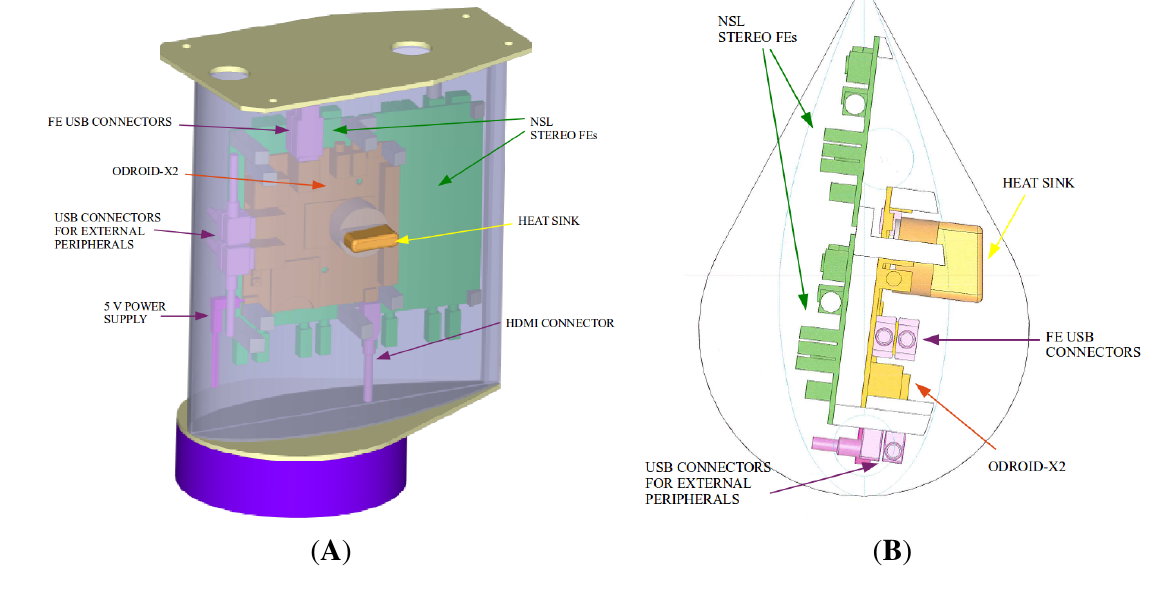
Figure 3. Three-quarter ( A ) and top ( B ) views of the sensor case 3D and 2D CADs, with the main internal components